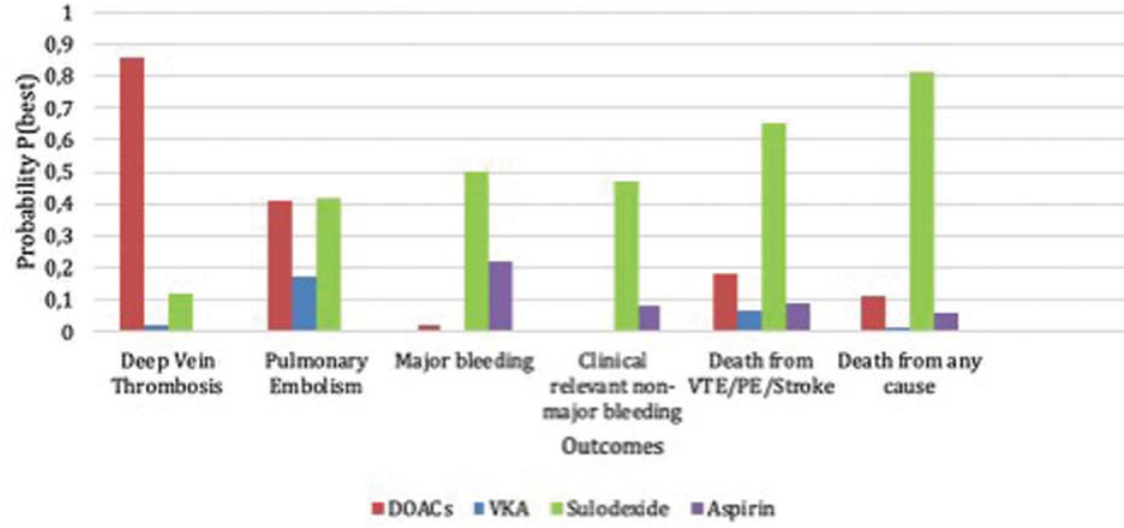
Fig. 2 Bar graph showing the probability to be better for each therapeutic approach for the main